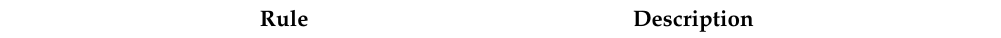
Table 5. Sample rule for boundary detection of requirement using Java Annotation Pattern Engine (JAPE) in